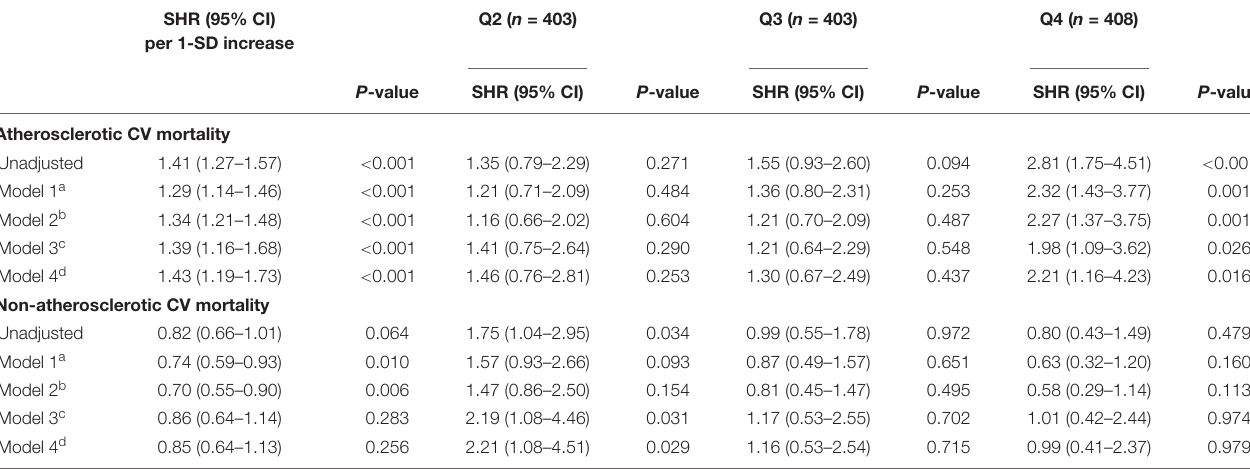
FIGURE 4 | Cumulative incidence function curves for the cumulative incidence of atherosclerotic (A) and non-atherosclerotic (B) CV mortality in participants categorized by apolipoprotein B/apolipoprotein A1 ratio quartiles. CV, cardiovascular; Q1–Q4, lowest to highest quartile. TABLE 3 | Association of apo B/apo A1 ratio with atherosclerotic and non-atherosclerotic CV